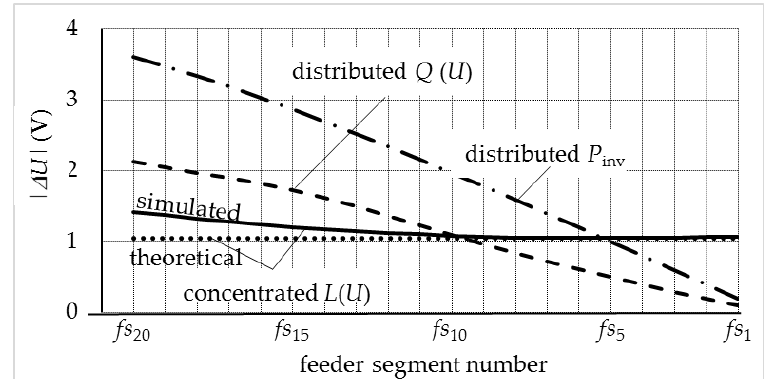
Figure 15. The amplitude of voltage drop in every feeder segment caused by distributed active power, an injection of PV facilities, P inv , distributed Q ( U ), and concentrated L ( U ) control strategies. Table 1. Reactive power consumption, loss, and exchange for different control strategies in the LV test grid. Q inv or Q c (kvar)